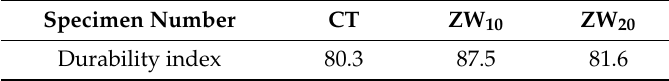
Table 10. Freeze–thaw resistance durability index of CANCP